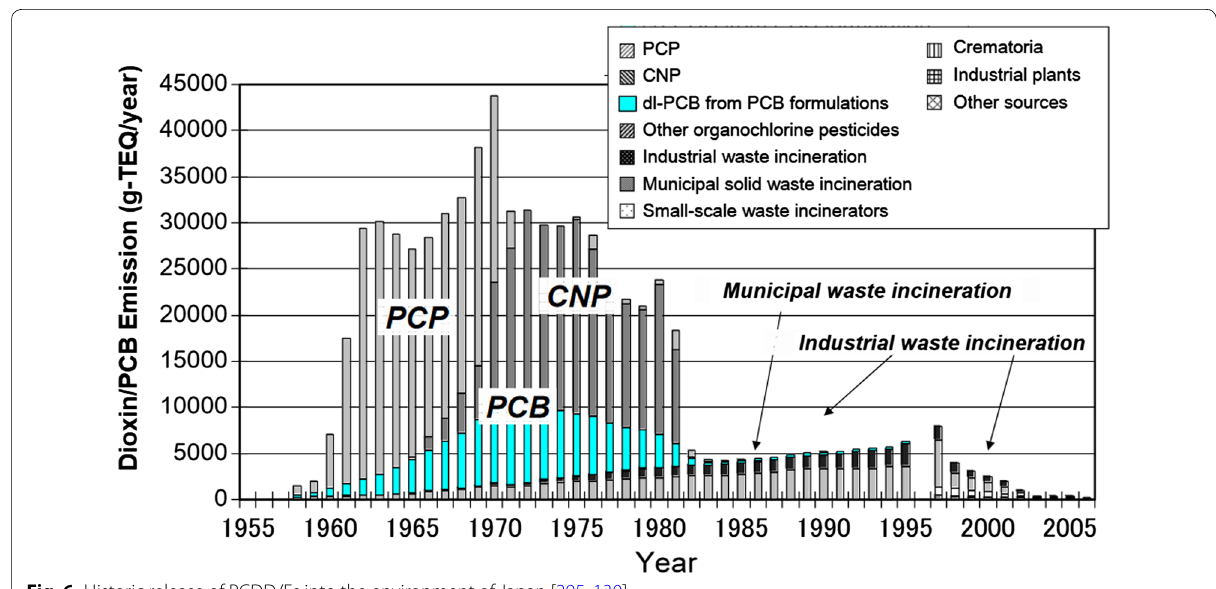
Fig. 6 Historic release of PCDD/Fs into the environment of Japan [295,